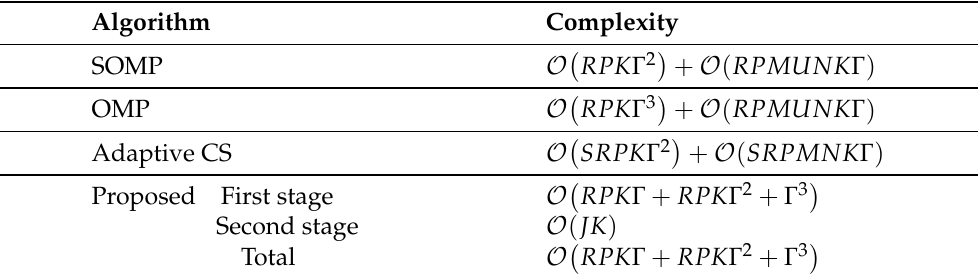
Table 2. Computational complexity of respective